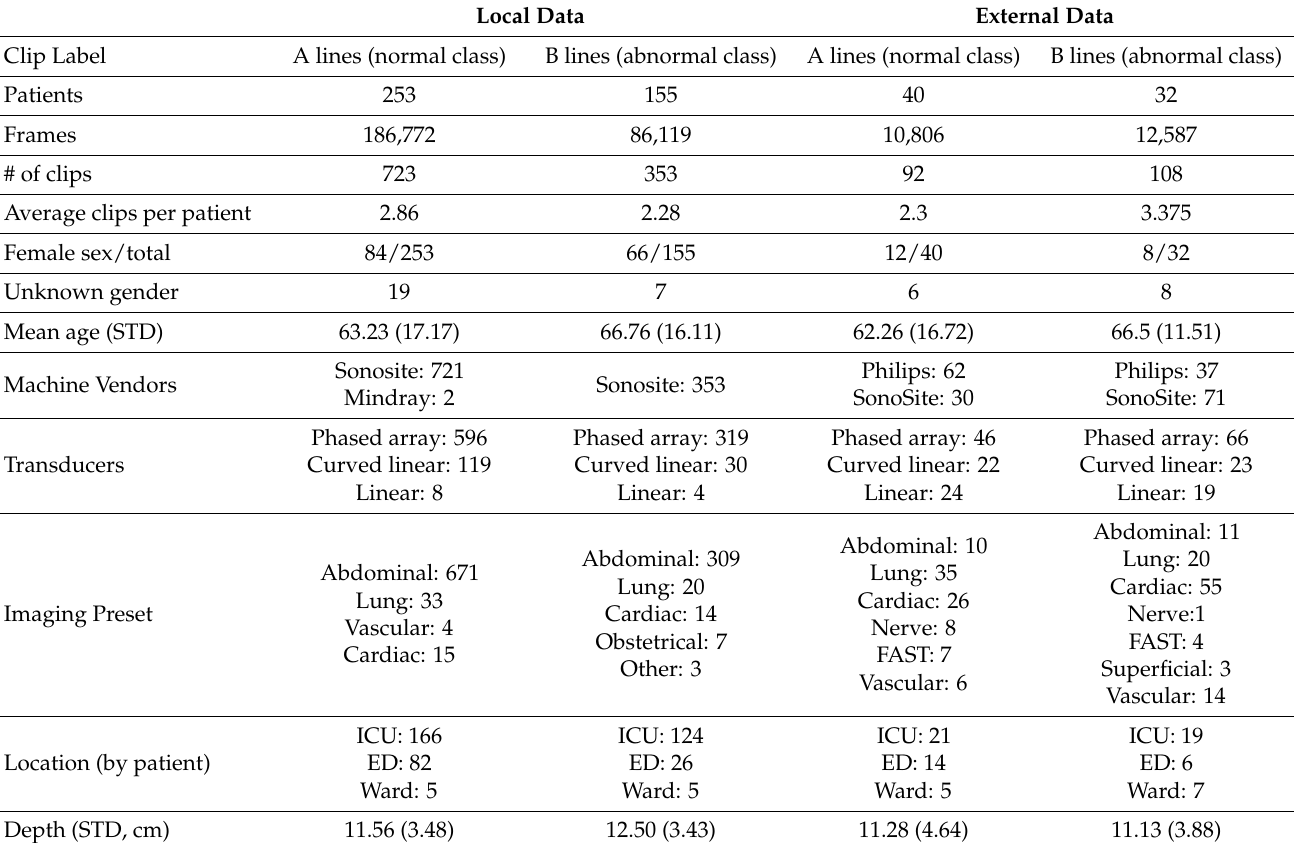
Table 1. Homogeneous ultrasound data characteristics used for frame-based classifier training and validation. ED, emergency department; ICU, intensive care